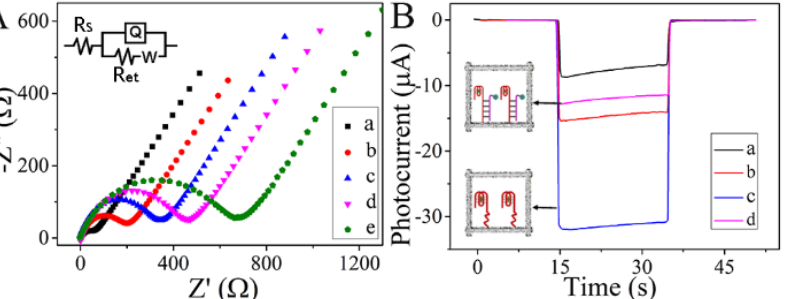
Figure 5. ( A ) EIS spectra of (a) PWE, (b) PWE/Cu 2 O, (c) PWE/Cu 2 O/CuO, (d) PWE/Cu 2